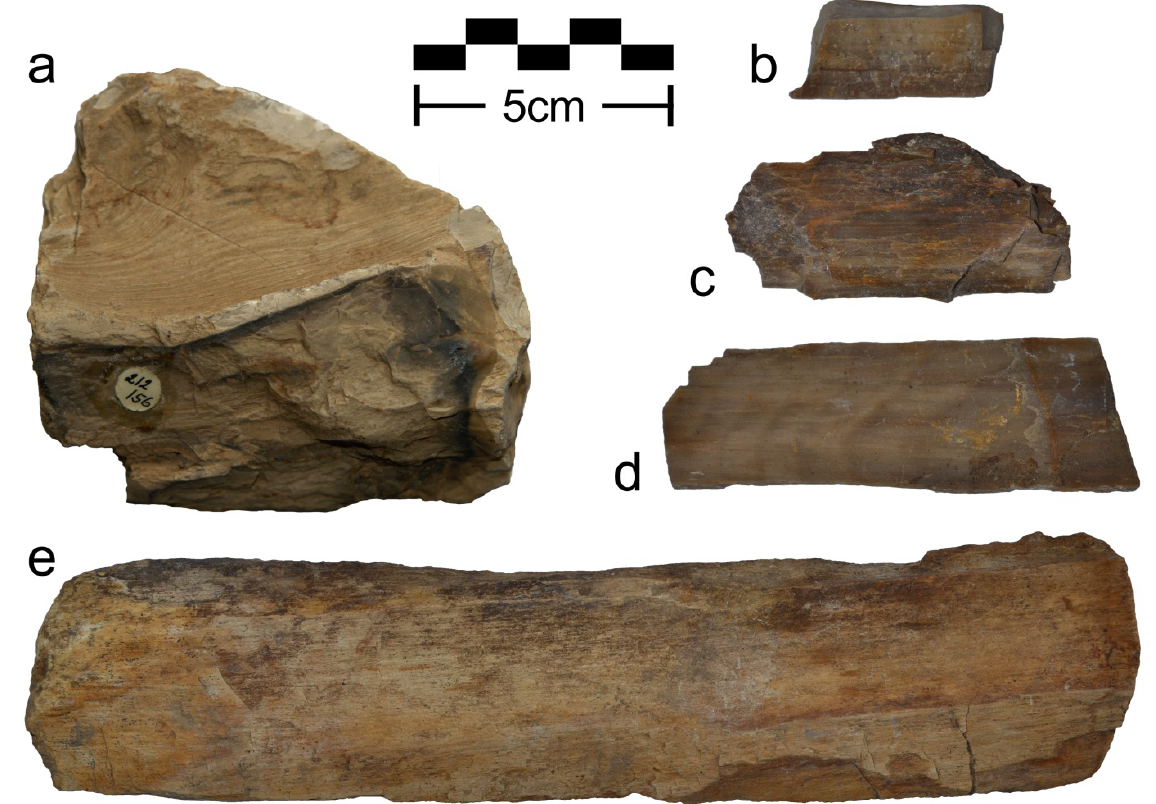
Figure 7. Silicified wood from a) Basarabeasa; b) to d) petrified forest near Ociu; e) valley south-west of